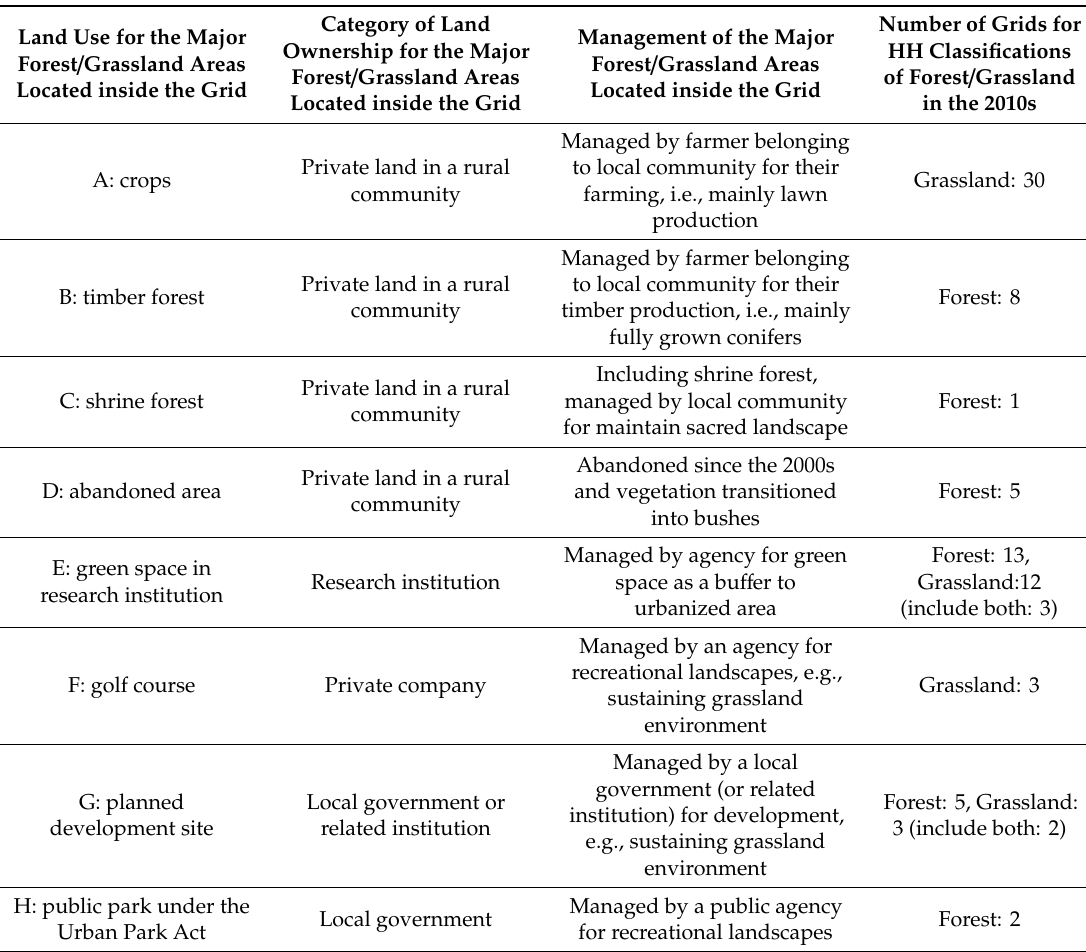
Table 1. Current land ownership and their management of urban nature in the 2010s where the high–high (HH) grid of “Grassland” or “Forest” is located (77 grids). Number of Grids for Category of Land Management of the Major Land Use for the Major HH Classifications Ownership for the Major Forest / Grassland Areas Forest / Grassland Areas of Forest / Grassland Forest / Grassland Areas Located inside the Grid Located inside the Grid in the Located inside the Grid